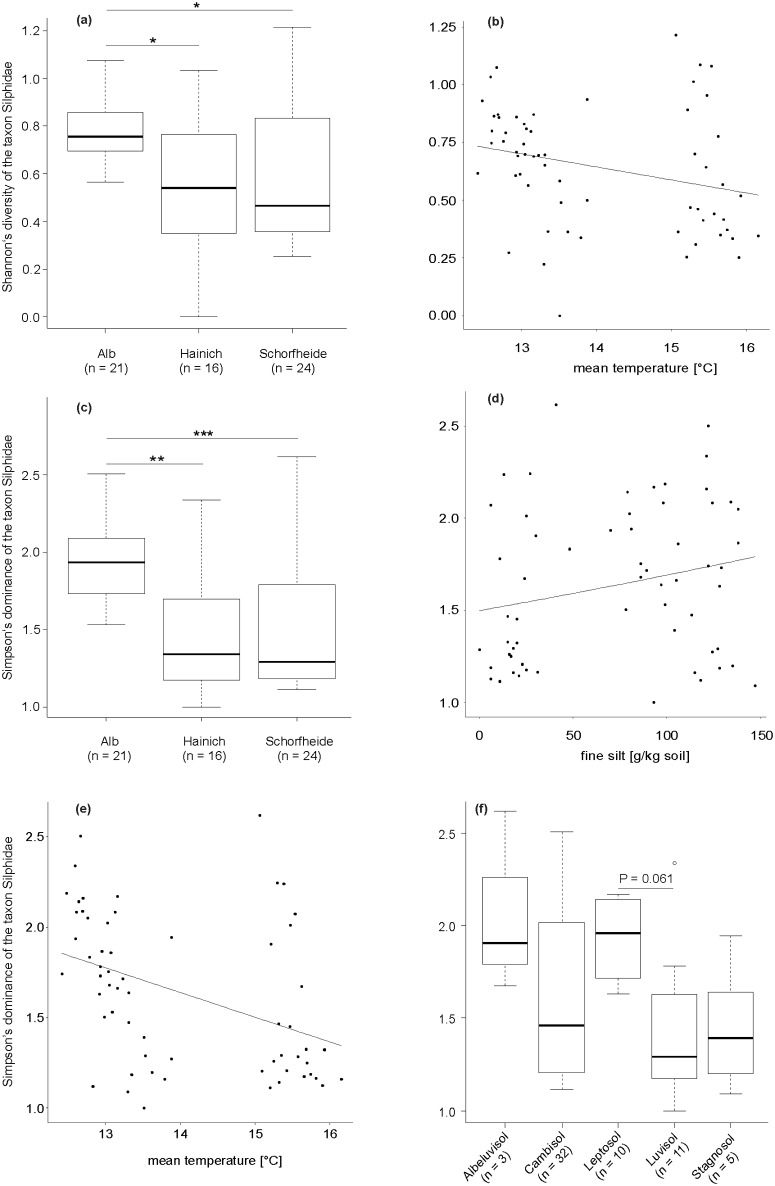
Effects of environmental characteristics on the diversity of the taxon Silphidae.Relationship between Shannon’s diversity of the taxon Silphidae and a region and b mean ambient temperature. Relationship between Simpson’s dominance of the taxon Silphidae and c region, d fine silt content, e mean ambient temperature, and f soil type (n = number of plots per soil type). Observed values (circles) and predicted values (connected by a line) for the Gaussian-GLMM model (b: deviance = 19.66, P = 0.001) and for gamma-GLMM models (d & e: deviance = 40.57, P < 0.001). a: box plot showing the median, the 75% percentile, the 25% percentile, the highest non-extreme value and the smallest non-extreme value inside a category (Gaussian-GLMM, deviance = 11.11, P = 0.011; Tukey tests, *P < 0.05), c: box plot showing the median, the 75% percentile, the 25% percentile, the highest non-extreme value and the smallest non-extreme value inside a category (gamma-GLMM, deviance = 25.15, P < 0.001; Tukey tests, **P < 0.01, ***P < 0.001), and f: box plot showing the median, the 75% percentile, the 25% percentile, the highest non-extreme value, the smallest non-extreme value, and the extreme values inside a category (gamma-GLMM, deviance = 40.57, P < 0.001; Tukey tests, P > 0.05).